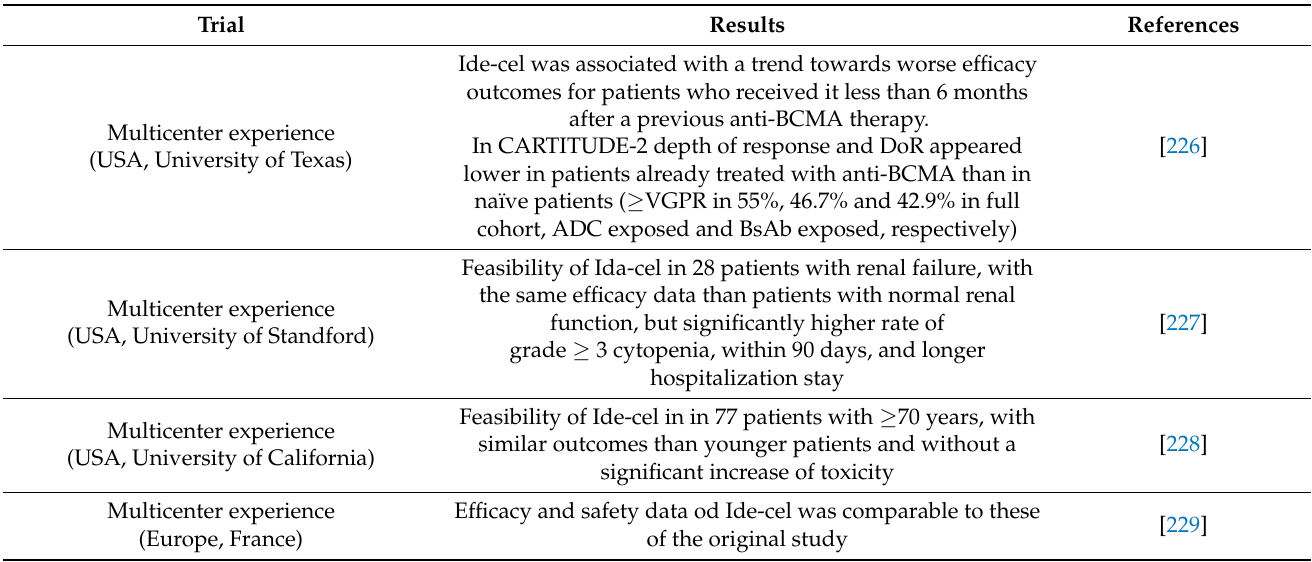
Table 6. Real life studies on